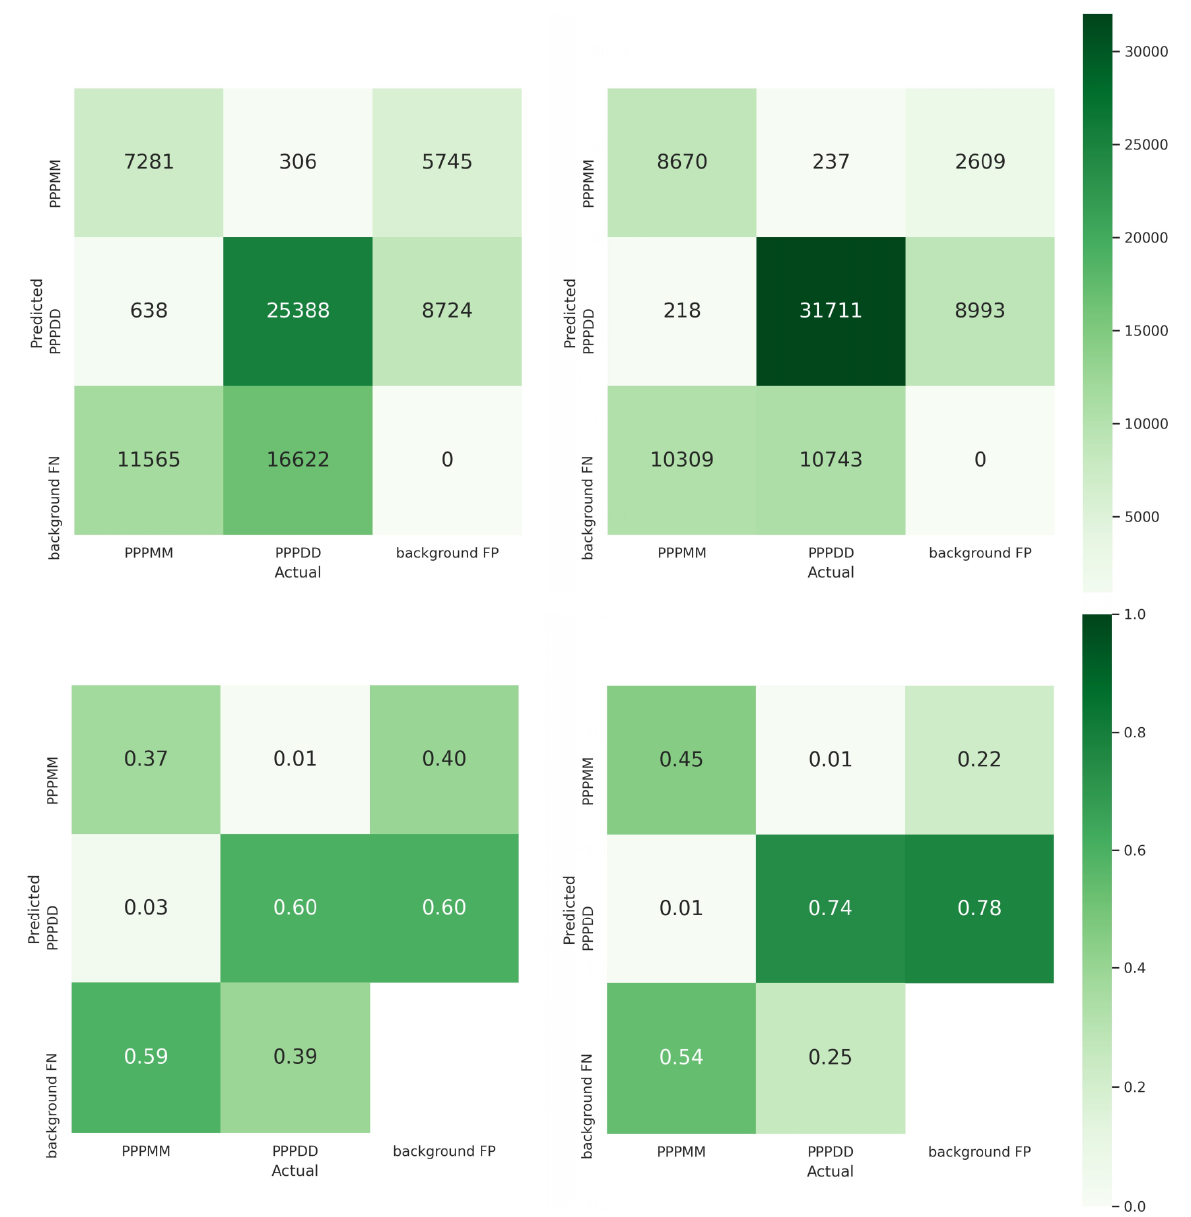
Figure 14. The normalized and non-normalized confusion matrices obtained from EfficientDet ( Left ) and YOLOv5 ( Right ) on the in-situ images.